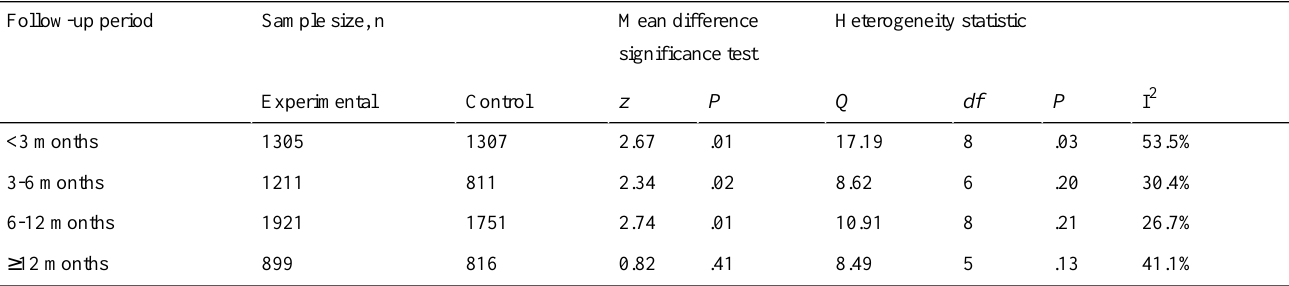
Table 4. Results of meta-analysis including significance test and heterogeneity statistics.